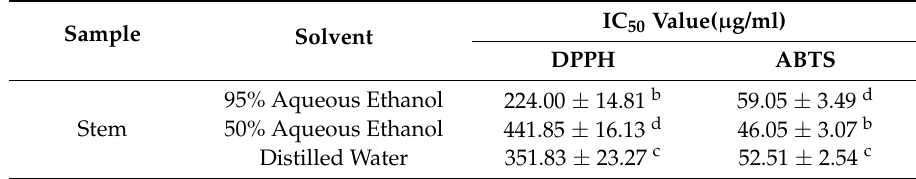
Figure 2. The antioxidant activity of crude extracts of Hylocereus polyrhizus parts, as measured by the 2,2 ′ -azino-bis (3-ethylbenzothiazoline-6-sulphonic acid) (ABTS) radical scavenging assay. WS, distilled water extract of stem; WP, distilled water extract of peel; WF, distilled water extract of flower; HS, 50% aqueous ethanol extract of stem; HP, 50% aqueous ethanol extract of peel; HF, 50% aqueous ethanol extract of flower; ES, 95% aqueous ethanol extract of stem; EP, 95% aqueous ethanol extract of peel; and, EF, 95% aqueous ethanol extract of flower. Table 3. The IC 50 value of radical scavenging for crude extracts from Hylocereus polyrhizus parts as measured via the 2-2-diphenyl-1-picrylhydrazyl (DPPH) scavenging assay and the 2,2 ′ -azino-bis (3-ethylbenzothiazoline-6-sulphonic acid) (ABTS) scavenging